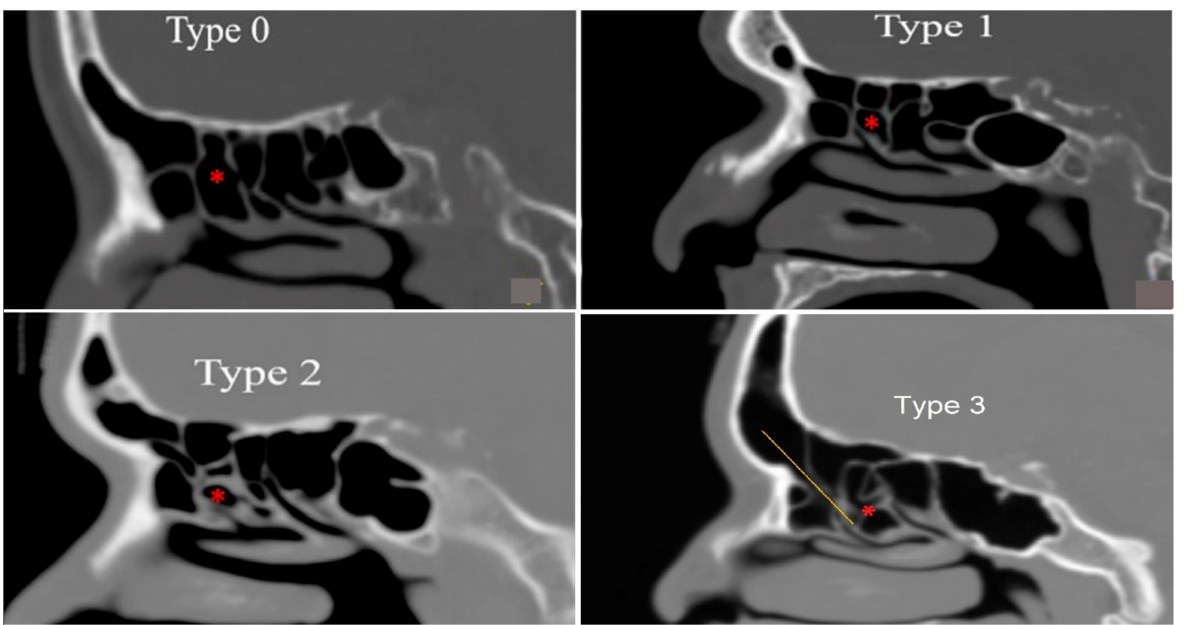
Figure 2. The suprabullar pneumatization is divided into four types based on the number and position of air cells in relation to the ethmoid bulla (red asterisk). Type 0 is absence of suprabullar air cells between ethmoid bulla and skull base, Type 1 is presence of a single suprabullar air cell between ethmoid bulla and skull base, Type 2 is presence of multiple suprabullar air cells above the ethmoid bulla without extension into the frontal sinus and Type 3 suprabullar cell is extension of suprabullar air cell into the frontal sinus displacing the frontal sinus drainage anteriorly (yellow line). Scale bar, 1 cm is equal to 5